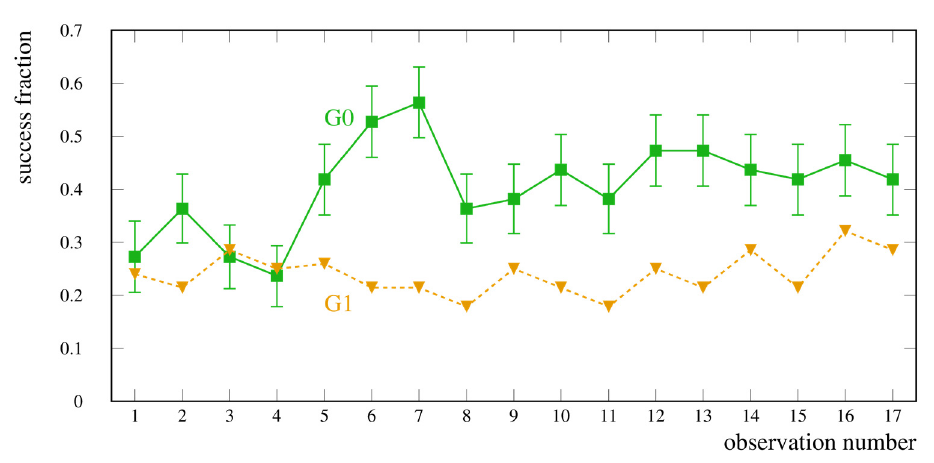
Figure 4. The time evolution of the success fraction in the test group, G0, and in the control group, G1. The bars correspond to ± one square root of the variation.